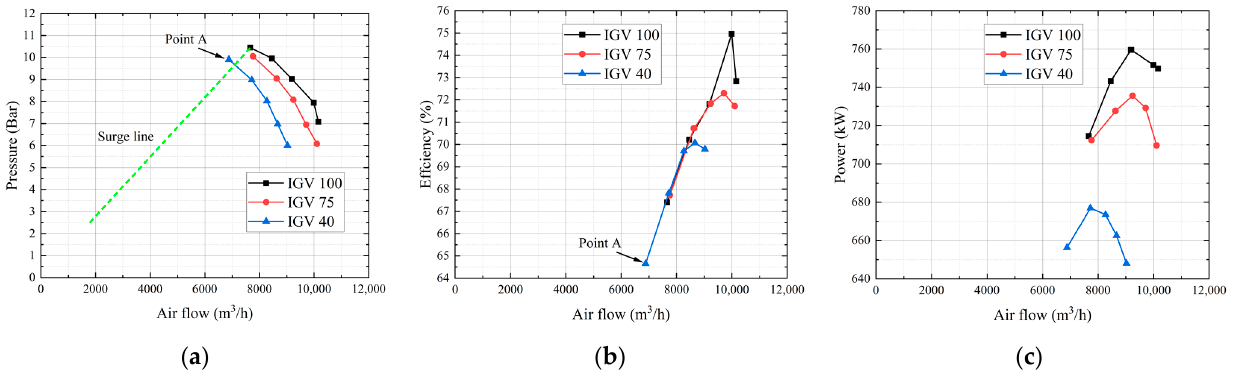
Figure 8. Performance curves of the TACCS using the constant speed drive (CSD). ( a ) Pressure curves; ( b ) isothermal efficiency curves; ( c ) power curves.